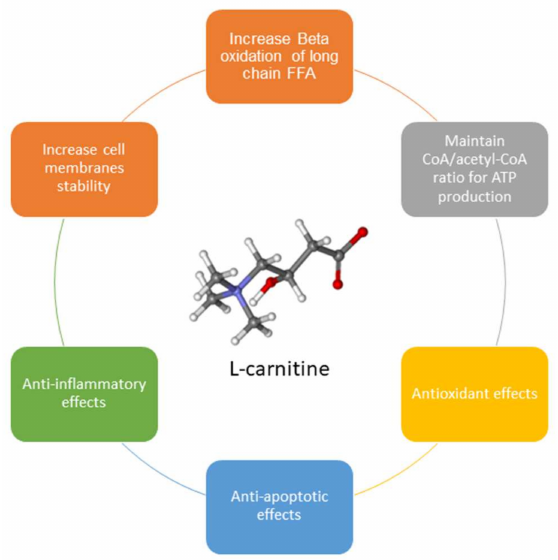
Figure 2. L-carnitine’s different